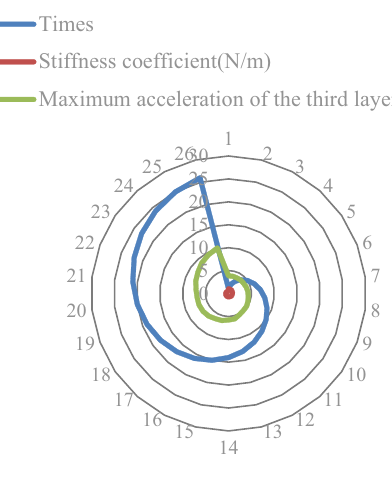
Figure 9: Fitting the polar